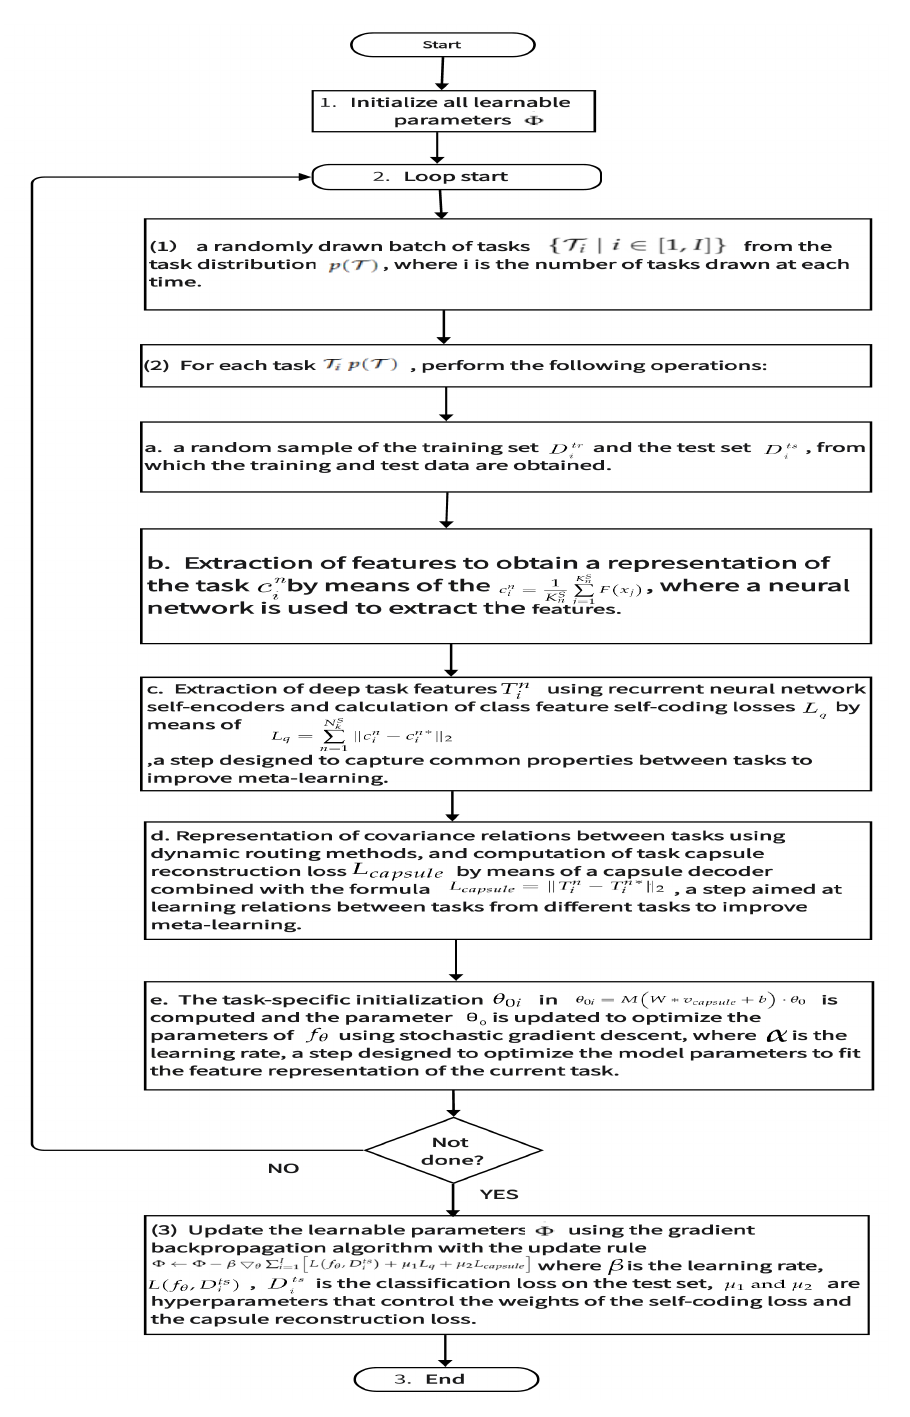
Figure 3. Algorithm flow diagram. The output t capsule of the capsule network is transformed into a vector form v capsule after being masked by Equation (6), which helps the modulation function of the fully connected form to modulate the learned